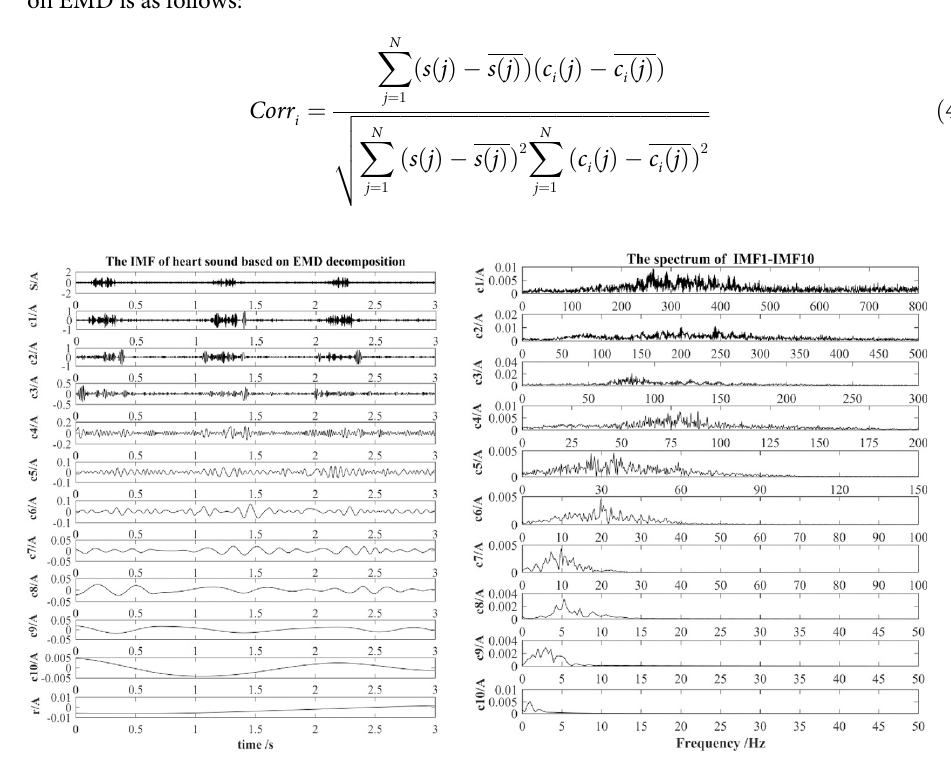
Fig 3. The EMD decomposition of heart sound. (a) Time domain; (b) Frequency